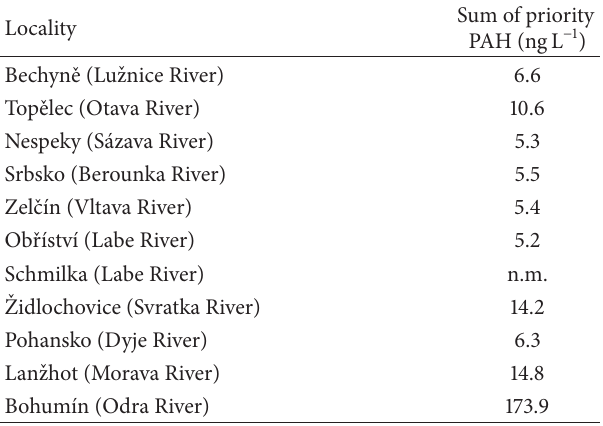
Table 1: Content of priority PAH in SPMD samples from sampling